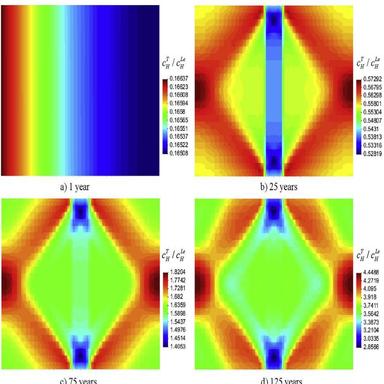
Equivalent plastic strain p distribution with time.